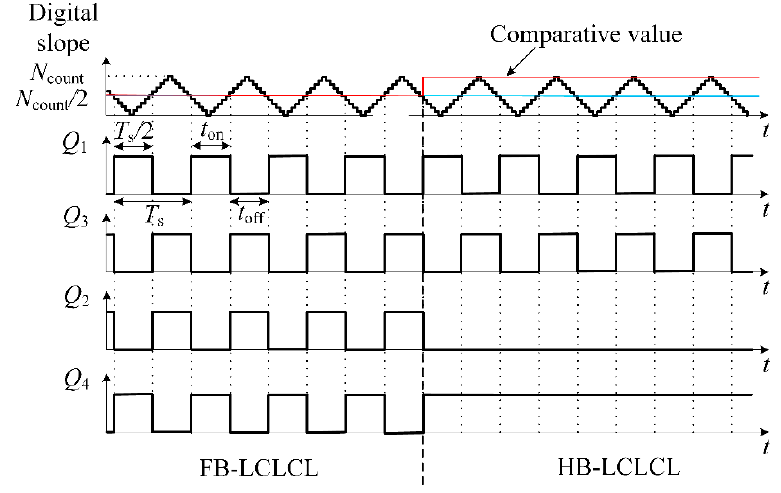
Figure 10. Adjustment of duty ratio for Q 1 – Q 4 with the traditional control method during transient switching process b.